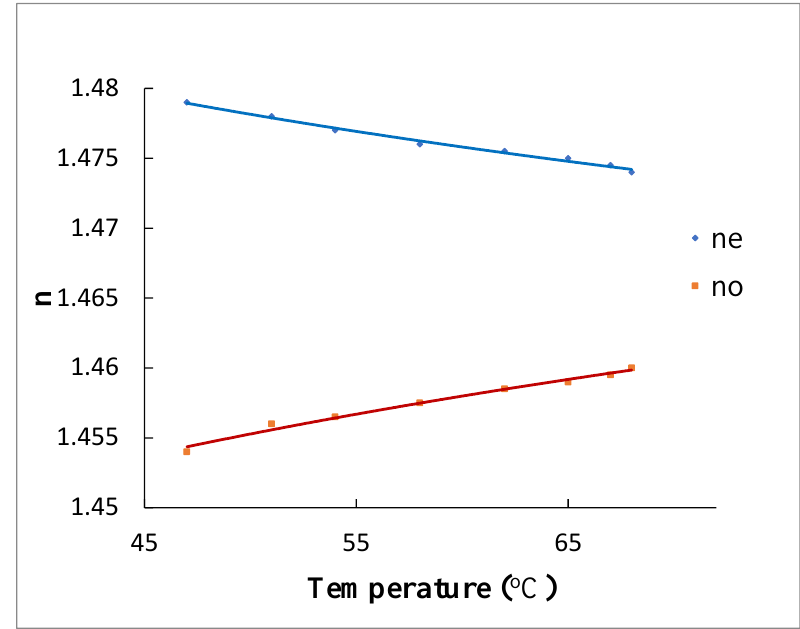
Figure 4. Temperature dependence of refractive indices n o and n e for compound I at 589.3 nm.